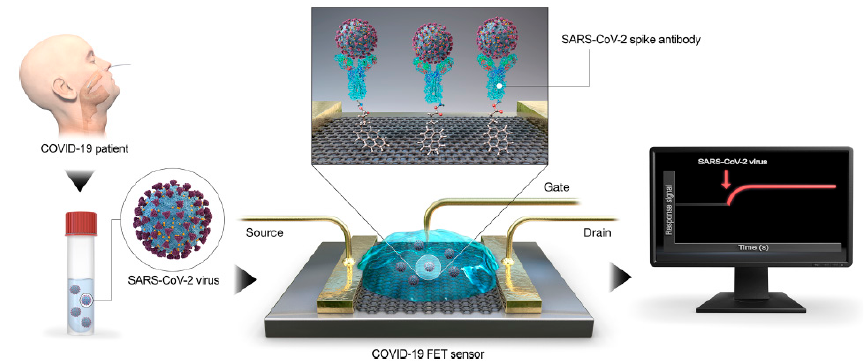
Figure 3. Coronavirus disease 2019 (COVID-19) field-effect transistor (FET)-sensor. Graphene is selected as sensing material and is decorated with the SARS-CoV-2 spike antibody using 1-pyrenebutanoic acid succinimidyl ester (PBASE) as interfacing molecule and probe linker. Reprinted with permission from reference [104], Copyright © 2020, American Chemical Society.